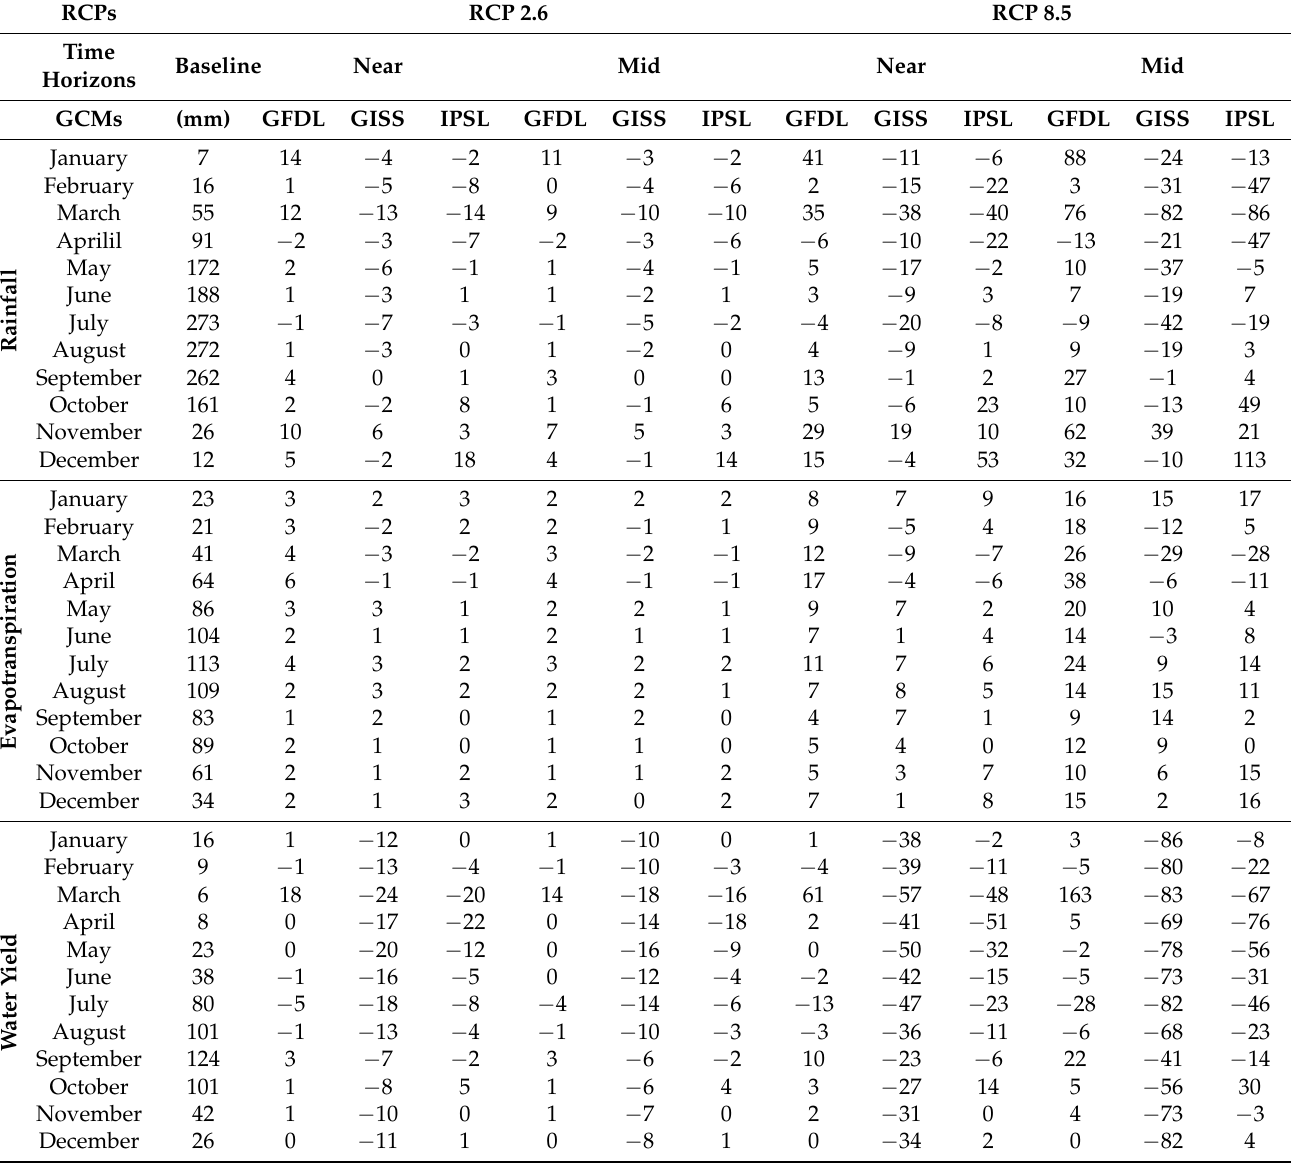
Table 7. Projected mean monthly water balance components and their percentage change in